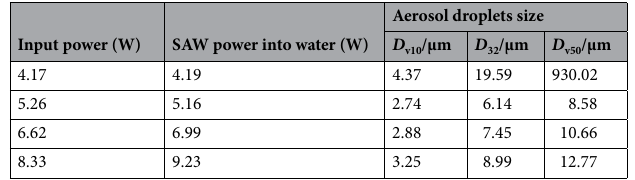
Table 1. Data of aerosol droplets size under different input power. D v10 —linear mean diameter. D 32 —Sauter mean diameter. D v50 —Volume median